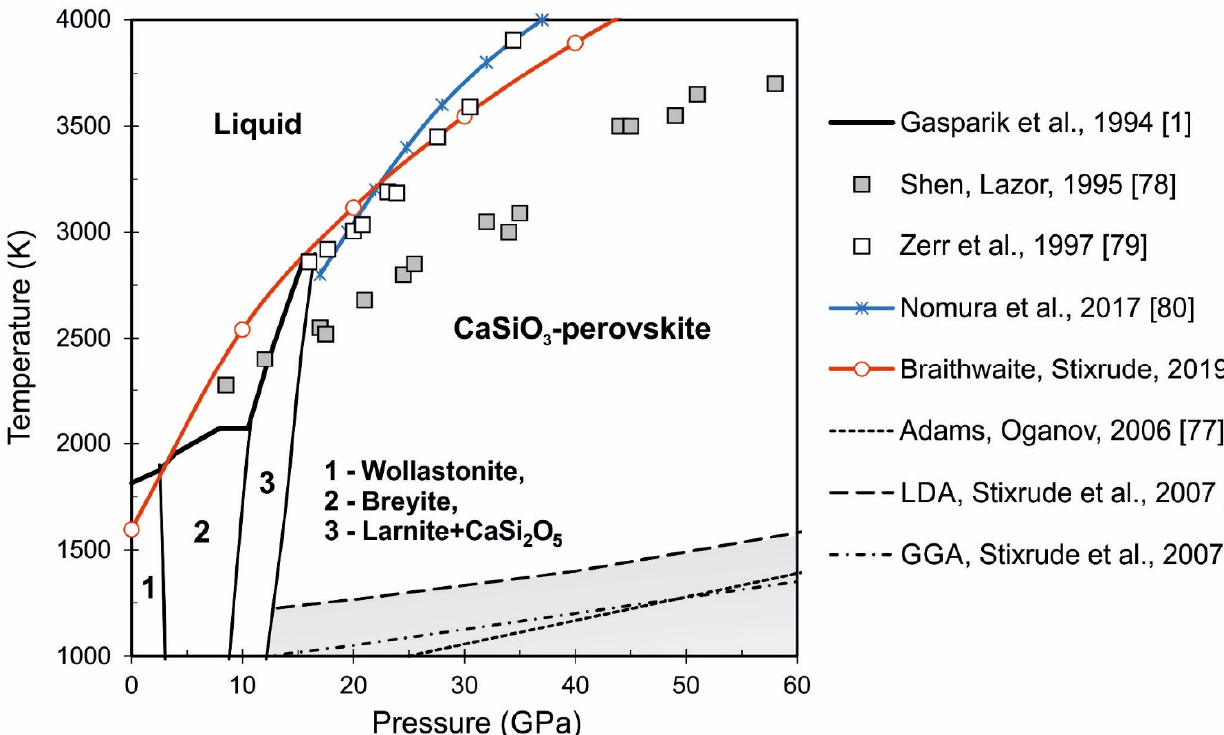
Figure 7. Phase diagram of the CaSiO 3 system under lower mantle P-T conditions. Thick black line, symbols, and color lines show melting line calculations from [1,78–81]; different dotted lines represent first-principle calculations of the phase boundaries in Ca-perovskite [73,77]. The gray area indicates the stability field of the tetragonal structure of Ca-perovskite.